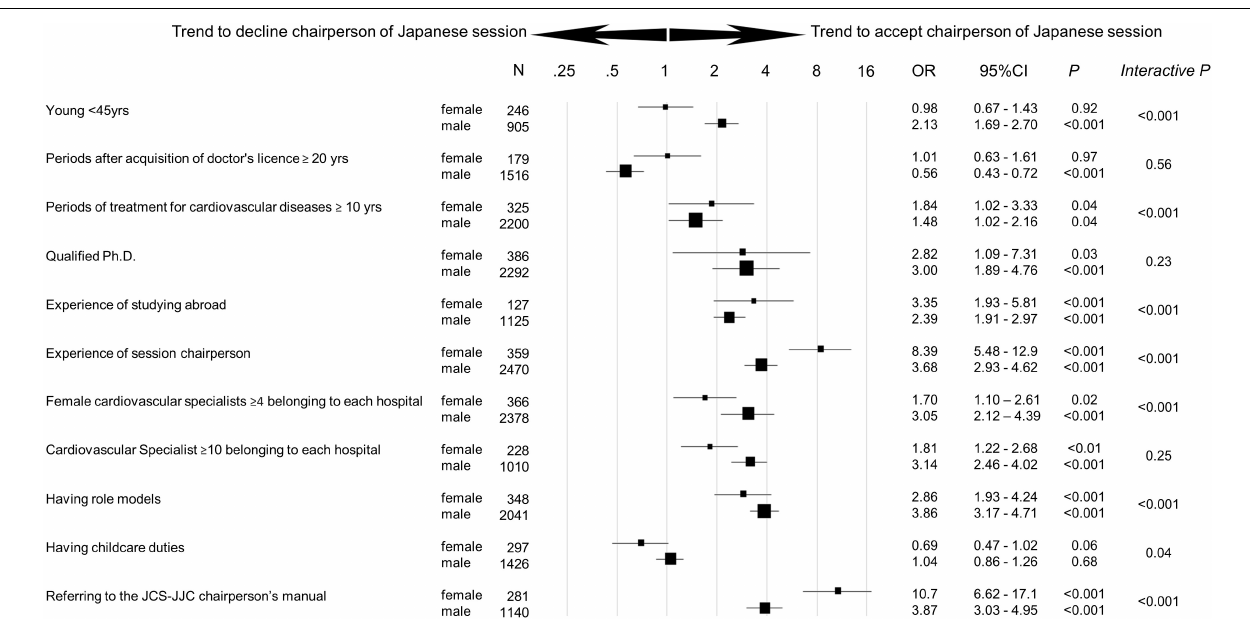
FIGURE 4 | Trend to accept chairperson of Japanese session by gender. Odds ratio [95% confidence interval ( CI )] for the trend to accept the chairperson of the Japanese session by gender was analyzed in each subgroup. Interactive p was used as an index to measure the strength of each factor within male vs. female group. Ph.D., Doctor of